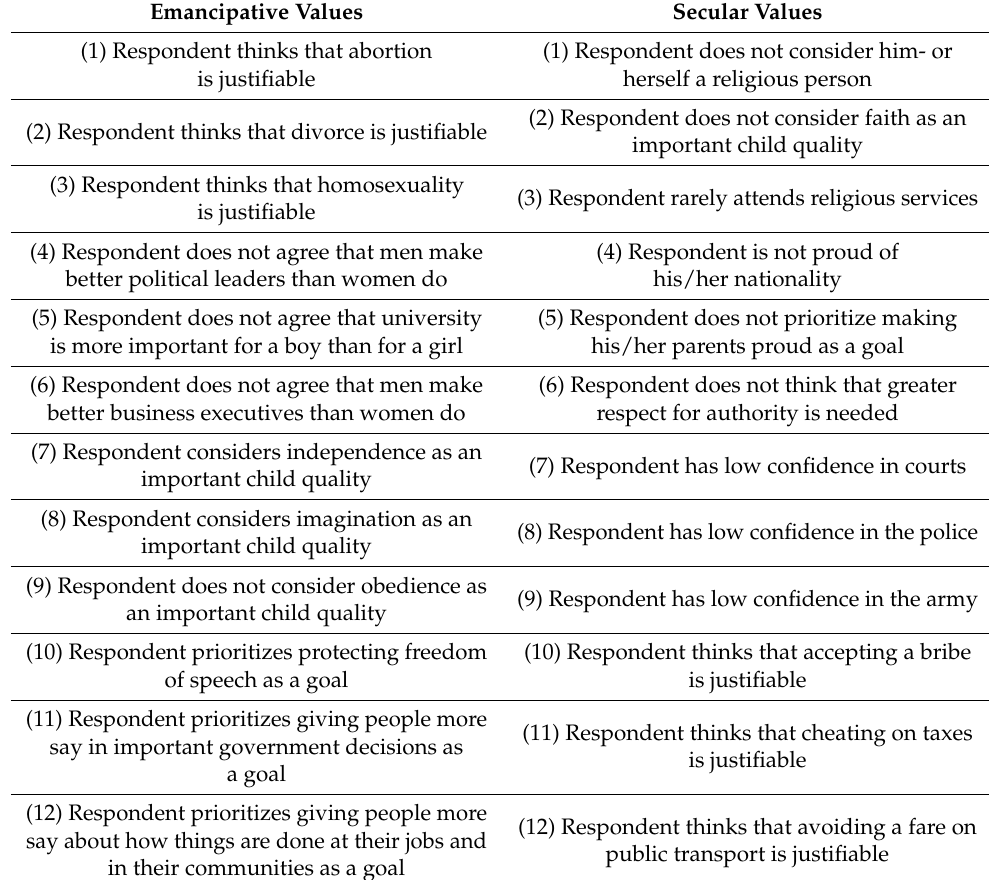
Table 2. WVS items used for constructing Welzel’s indexes of secular and emancipative values. Emancipative Values Secular